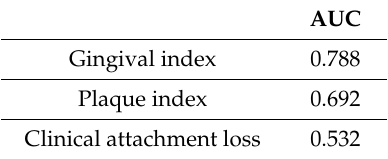
Table 4. Area under ROC curve (AUC) of clinical